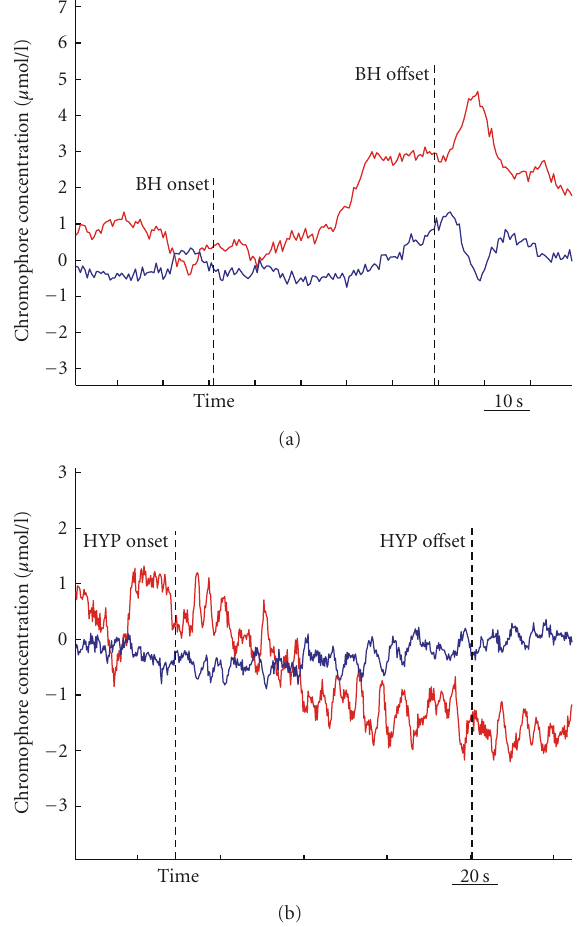
Figure 1: NIRS signals recorded on a healthy woman performing breath-holding (a) and hyperventilation (b). The red line represents the O 2 Hb concentration signal, the blue line the HHb. The black vertical dashed lines mark the onset and o ff set of the breath-holding (a) and hyperventilation (b). The graphs show that the NIRS signals become nonstationary as consequence of the active